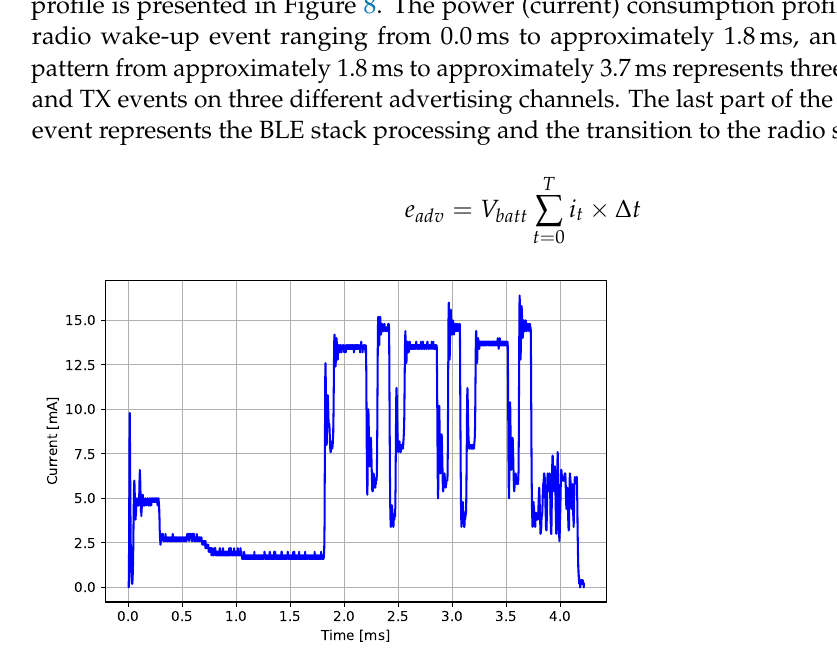
Figure 8. Current consumption profile of an advertising